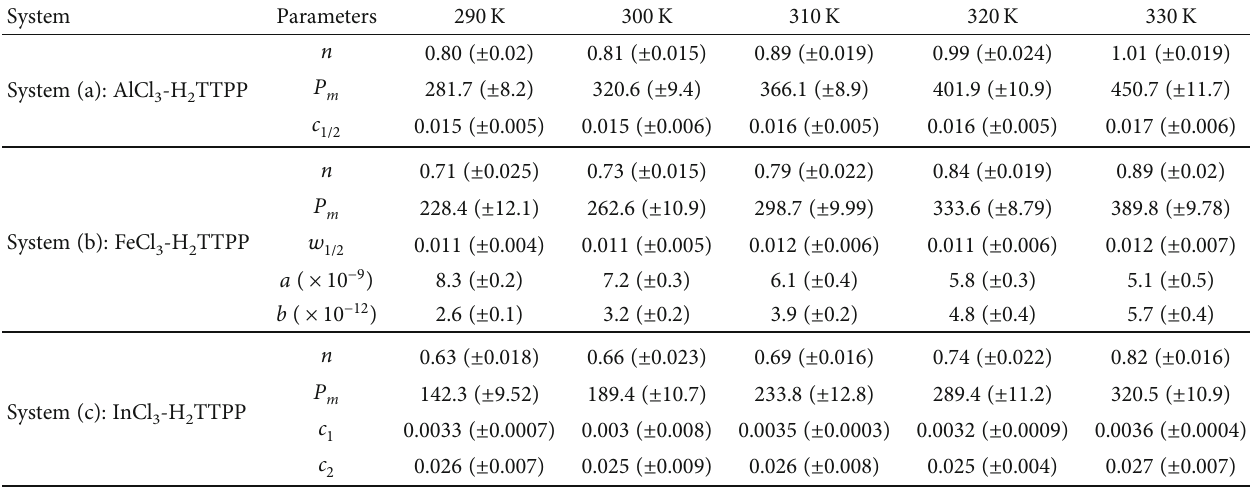
Table 4: Values of the physicochemical variables ( n , P